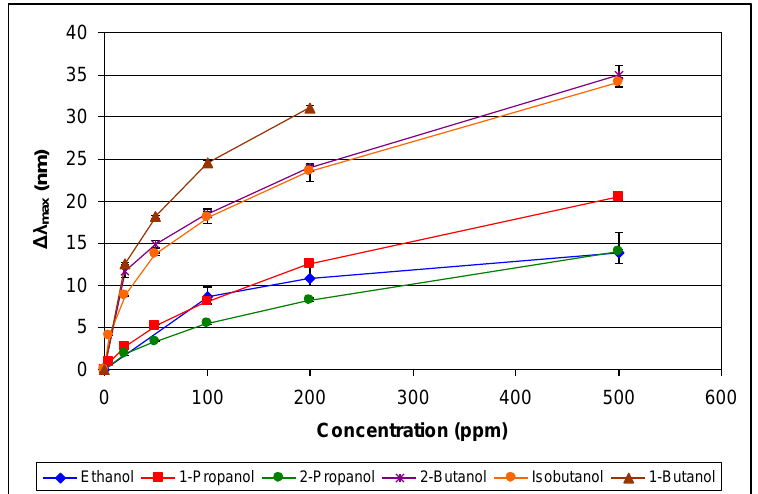
Figure 7. Response of sensor to alcohols at various concentrations.